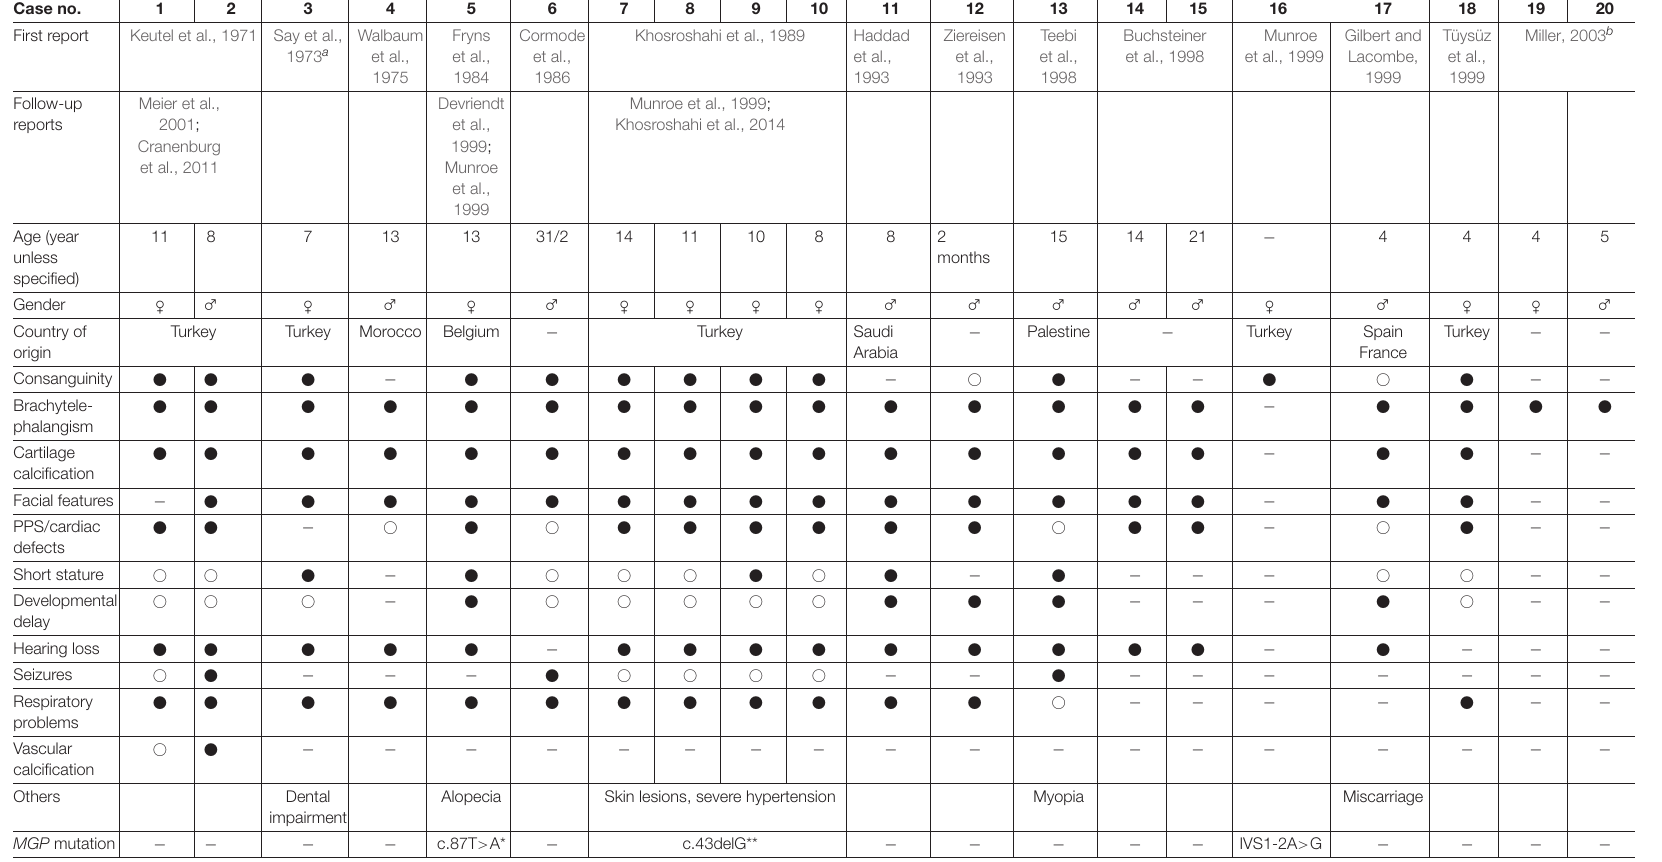
TABLE 1 | Clinical characteristics of Keutel syndrome. Case